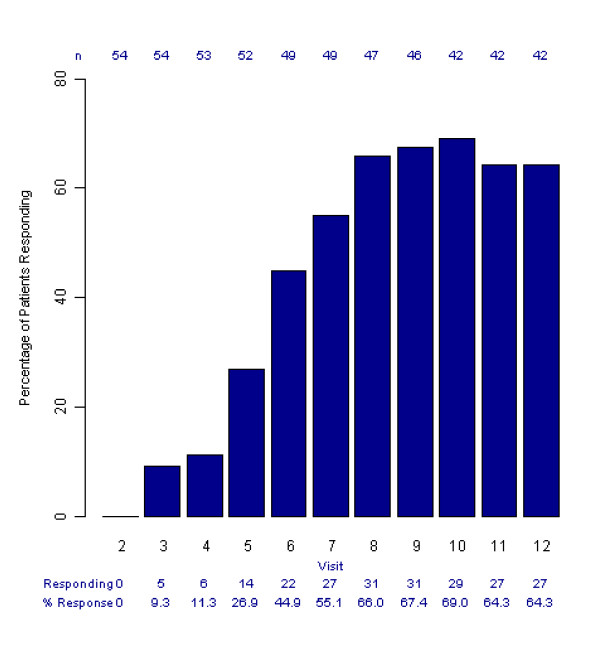
Percentage of patients responding per visit, all patients (observed cases per visit). Response was defined as a 50% decrease in MADRS from baseline MADRS score. Visits (Week) 1 (0), 2 (2), 3 (4), 4 (6), 5 (8), 6 (12), 7 (16), 8 (20), 9 (24), 10 (28), 11 (32) and 12 (34)